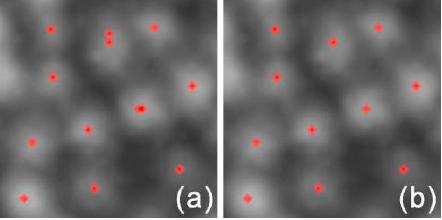
Figure 6. Duplicate identification removal. Identified cone cells are marked in red on the denoised AO-SLO image patch ( a ) before and ( b ) after duplicate identification removal.